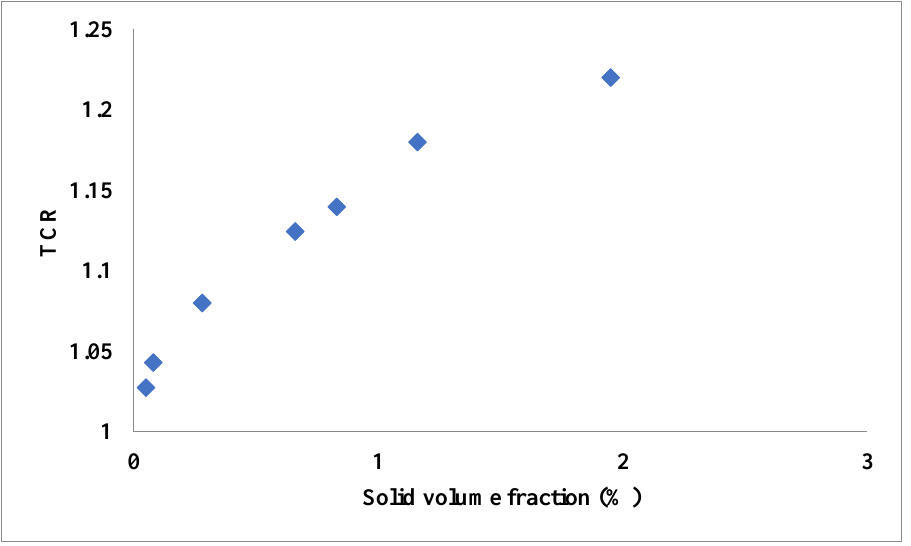
Figure 1. Effect of solid VF and temperature on TCR of SiO 2 -MWCNT (85:15%)/EG. Adapted from Ref. [35].